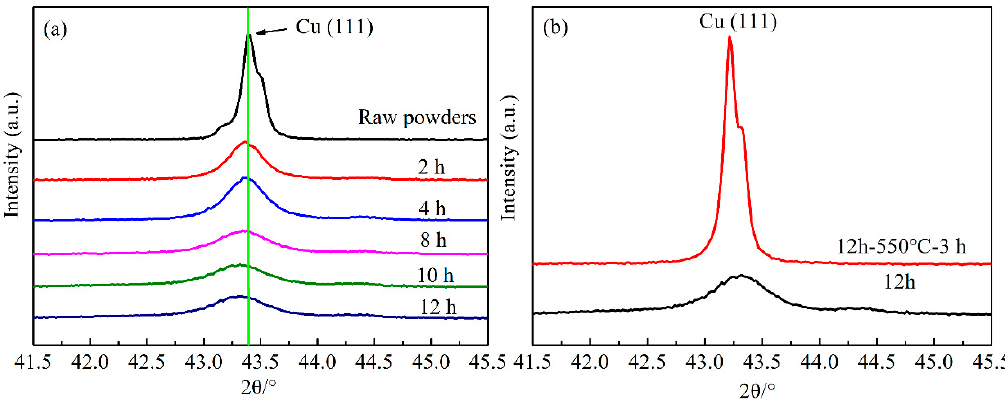
Figure 3. XRD patterns of Cu-Cr powders: ( a ) pattern changes as a function of milling time; ( b ) comparison of Cu (111) peak in the final samples before and after aging treatment.